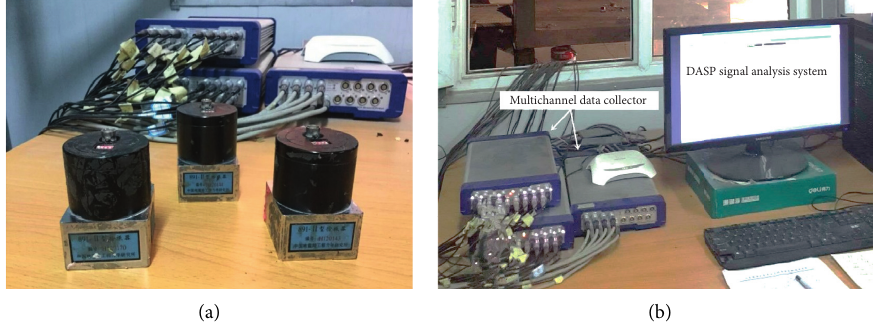
Figure 6: (a) 891-2 acceleration sensor and (b) data acquisition and analysis